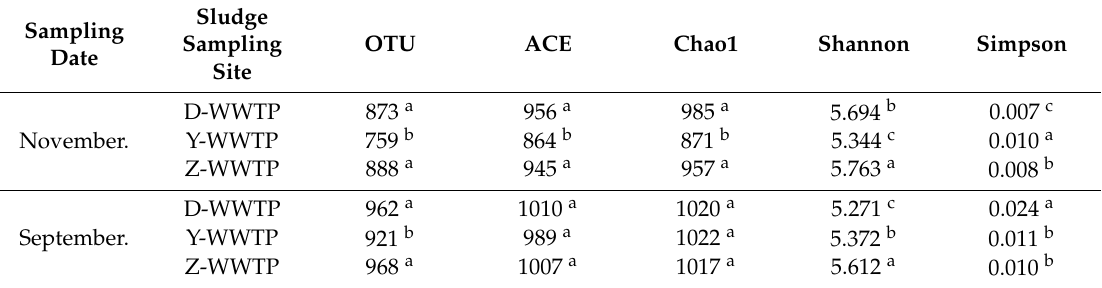
Table 2. Microbial community richness and diversity indices for sludge samples collected from di ff erent wastewater treatment